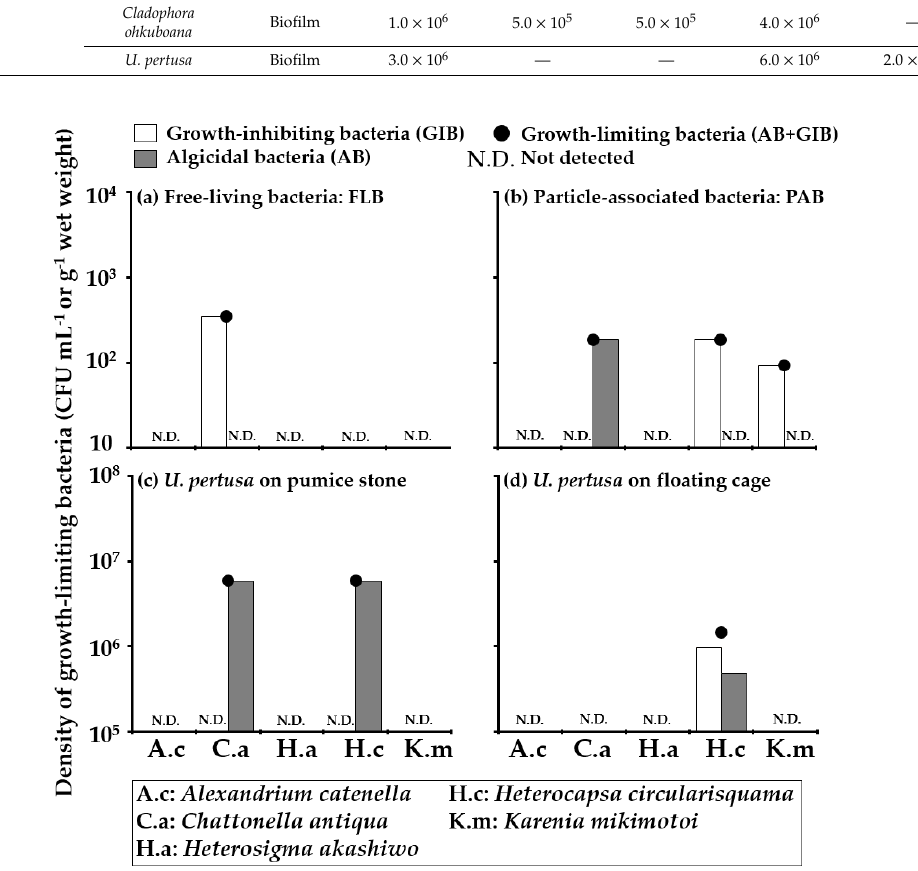
Figure 5. The densities of growth-limiting bacteria detected from seawater ( a ): FLB, ( b ): PAB and four macroalgal species ( c ): S. dupulicatum , ( d ): G. elegans , ( e ): C. ohkuboana and ( f ): U. pertusa collected at Stn.2. The densities of growth-limiting bacteria ( ●) are expressed as the sum of algicidal bacteria (AB: ) and growth-inhibiting bacteria (GIB: ). The tested HAB species and their abbreviations are displayed at the bottom.